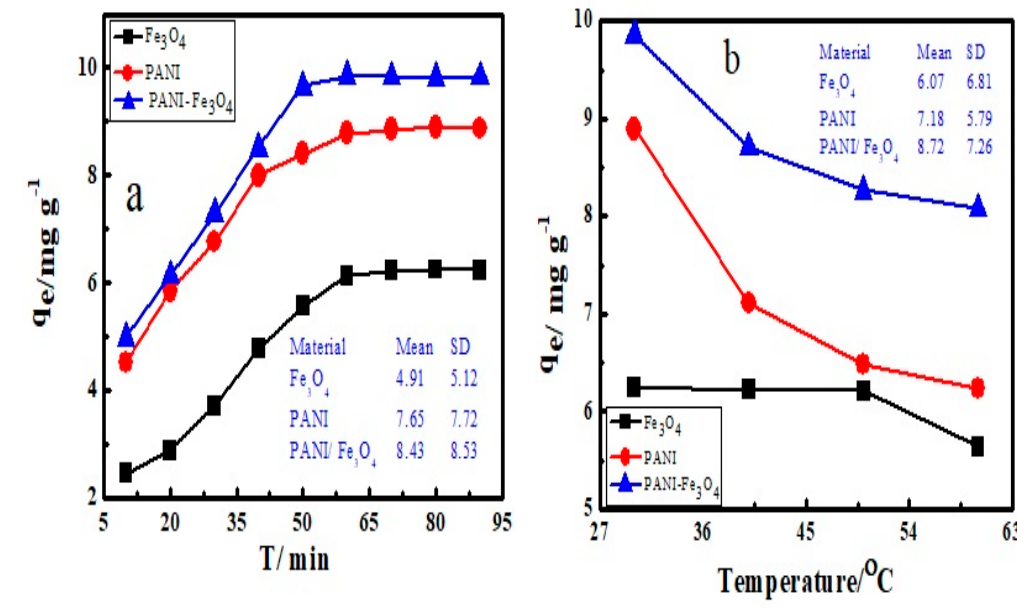
Figure 10. Adsorption of BB3 at ( a ) different time intervals and ( b ) temperature on Fe 3 O 4 , PANI, and PANI/Fe 3 O 4 composites.